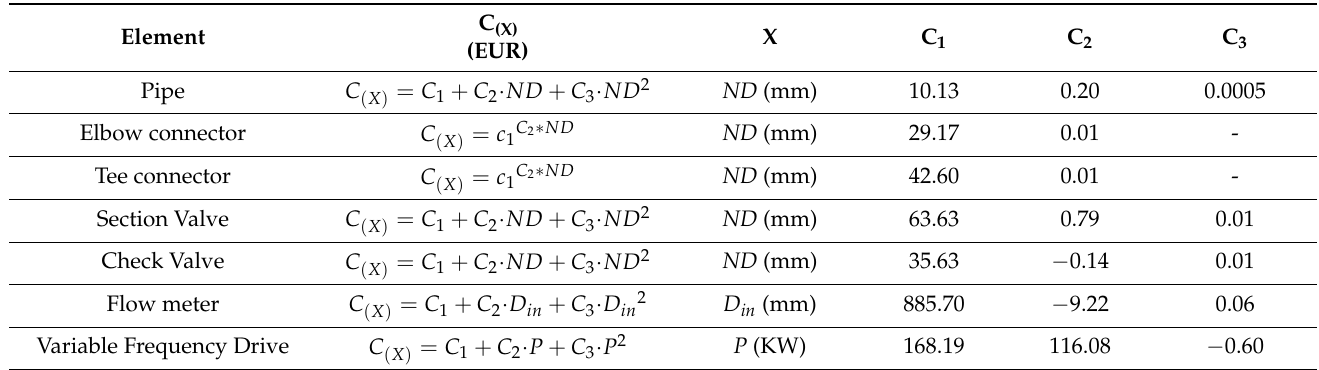
Table A1. Function cost of different elements in a